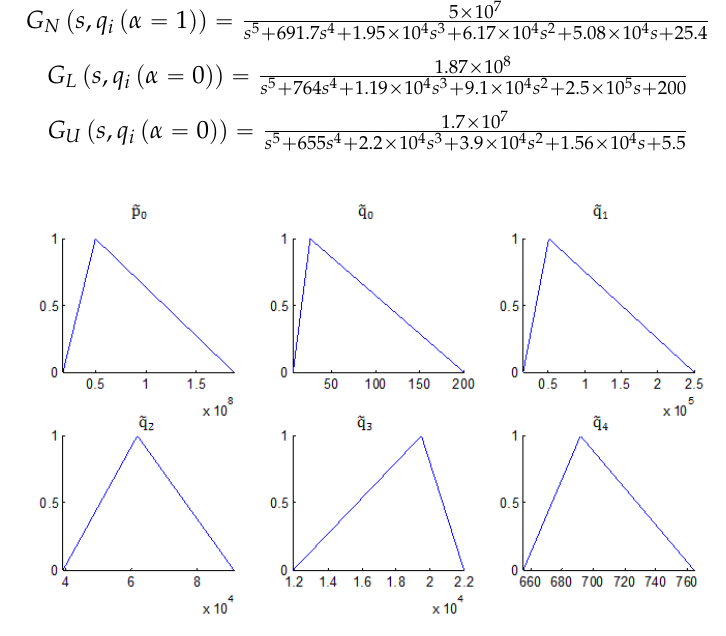
r p , r q , r q , r q , r q and r q 0 0 1 2 3